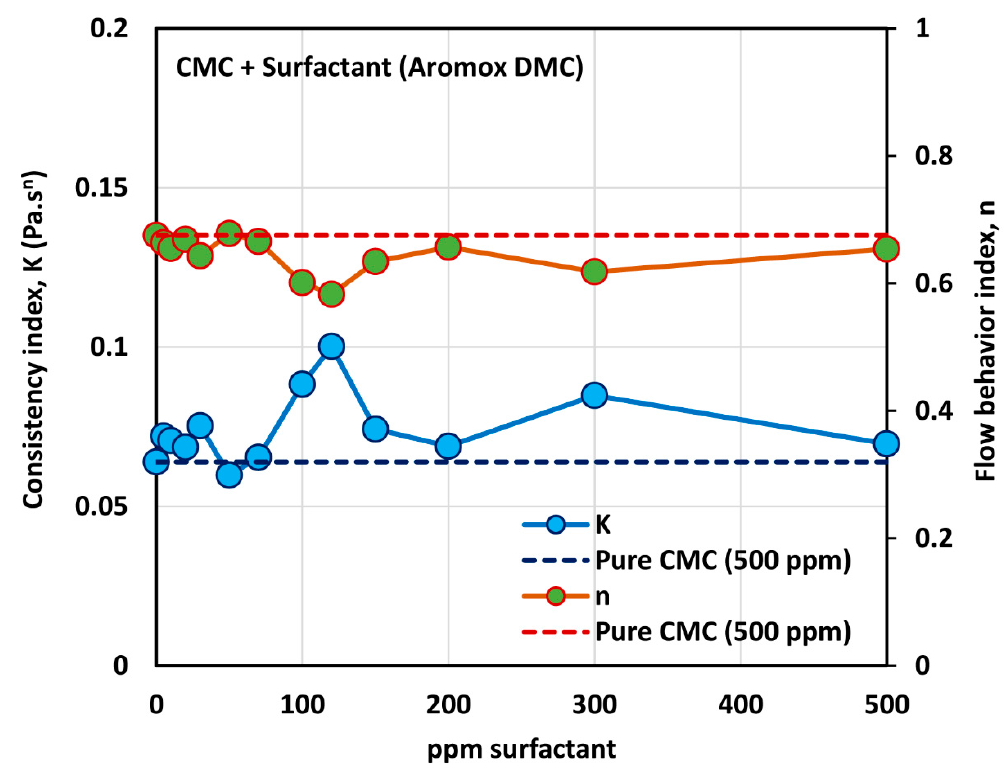
Figure 15. Variations of consistency index, K , and flow behavior index, n , for mixtures of anionic polymer, CMC, and non-ionic surfactant, Aromox DMC, with the increase in surfactant concentration, at a fixed polymer concentration of 500 ppm.